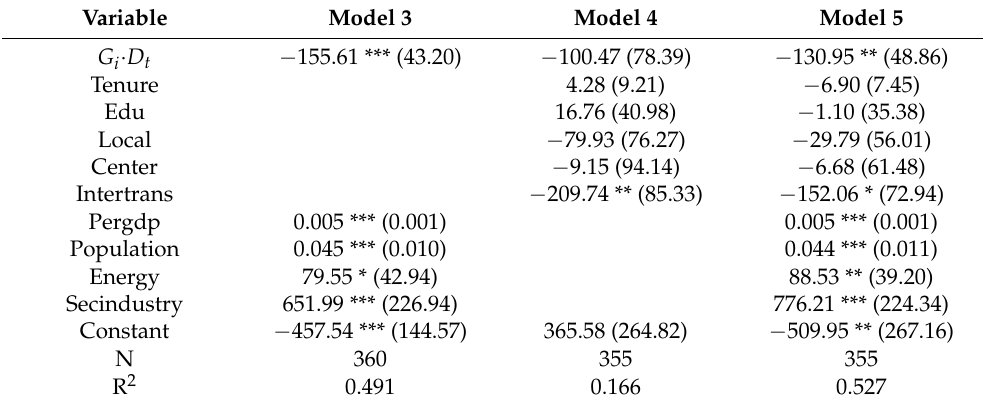
Table 4. Influence of the carbon emission trading policy on carbon emission reduction